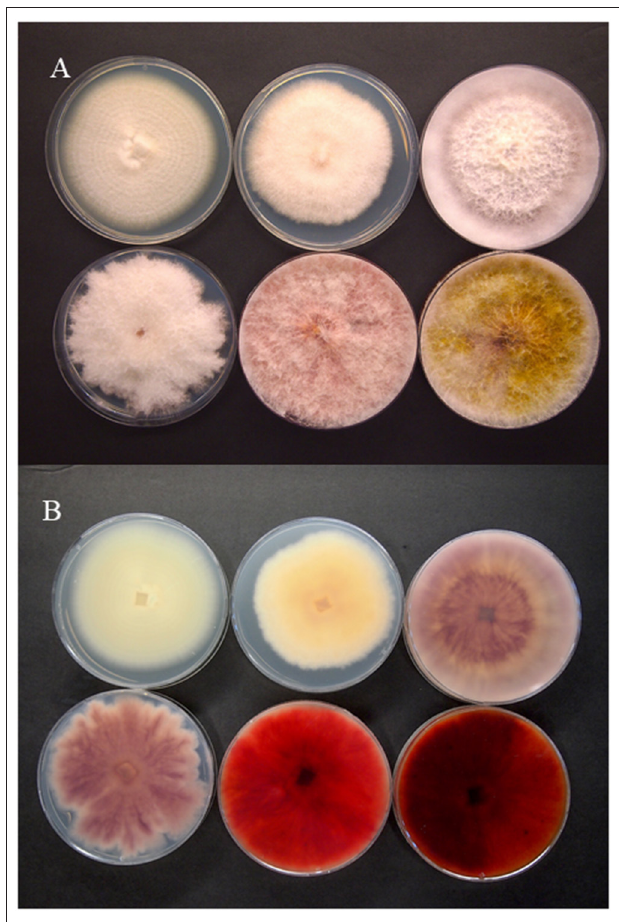
FIGURE 2 | Colony morphology of selected Fusarium species pathogenic on Cannabis sativa . The pathogens are top row, left to right— F. solani, F. equiseti, F. oxysporum, and bottom row, left to right— F. proliferatum, F. sporotrichioides, F. graminearum . (A) Colony viewed from above; (B) underside of the colony Photographs courtesy of Zamir